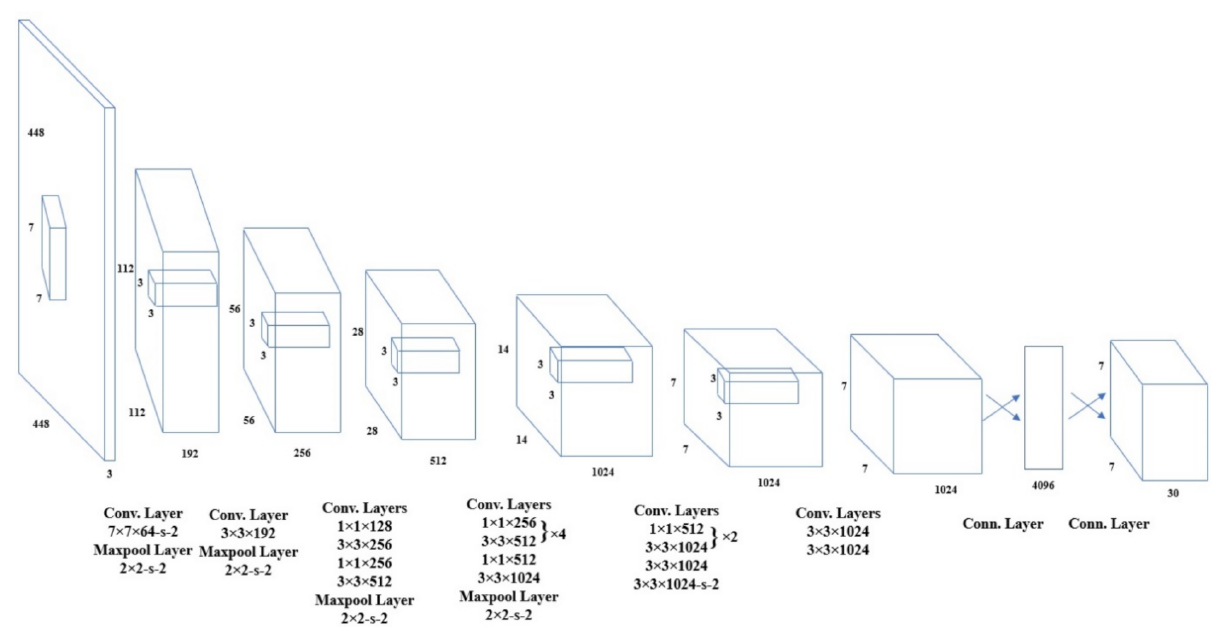
Figure 3. YOLO network architecture (adapted from [65]). The YOLO network has 24 layers followed by two fully connected